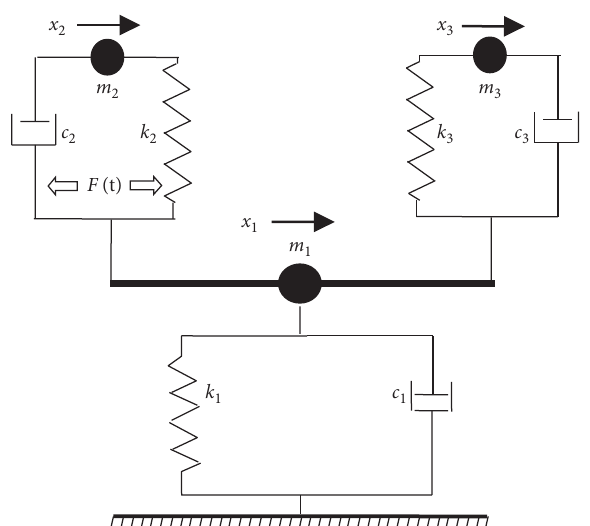
Figure 12: Three lumped-DOF representation of crowd–structure interaction